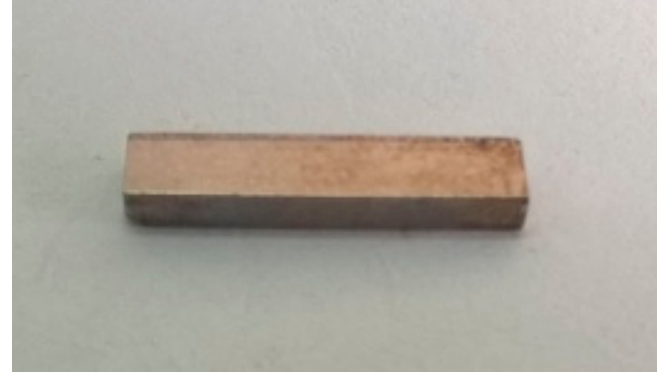
Figure 1. Sample of magnetic controlled shape memory alloy (MSMA) for the experiment.